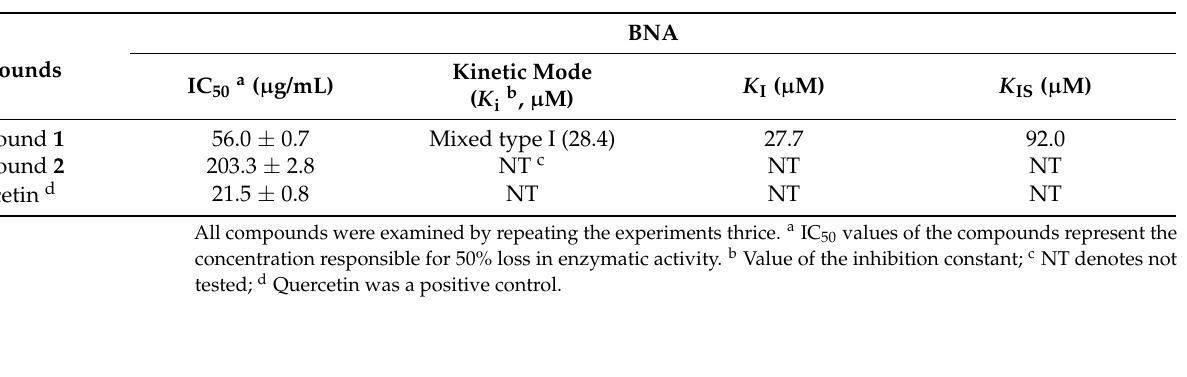
Figure 3. Inhibitory activity and mechanism of action of compounds against bacterial neuraminidase (BNA). ( a ) Dose − dependent inhibition of BNA by compound 1 , compound 2 , and quercetin (positive control). ( b ) Reversibility of the inhibitory effect of compound 1 . ( c ) Lineweaver − Burk plots for BNA inhibition by compound 1 . ( d ) Dixon plots of BNA inhibition by compound 1 . (Inset) Tendencies of the intercept and slope from each straight line of the Lineweaver − Burk plot. Table 1. Inhibitory effects of isolated compounds on bacterial neuraminidase (BNA)